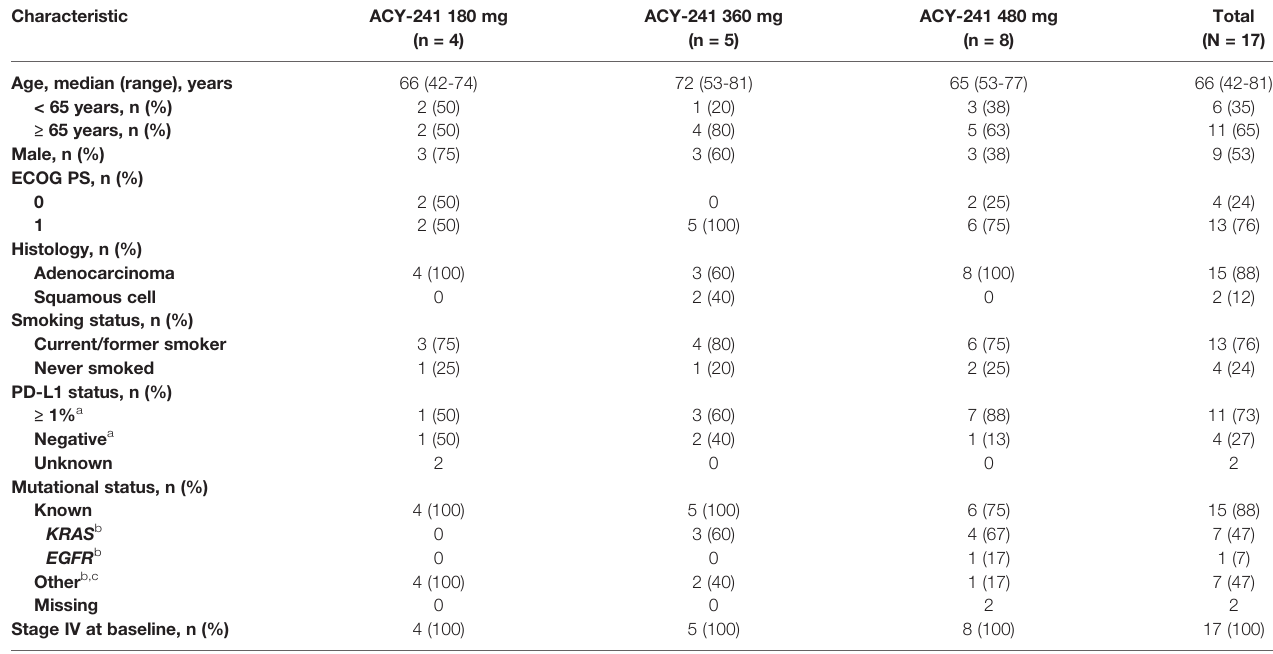
TABLE 1 | Baseline characteristics (safety